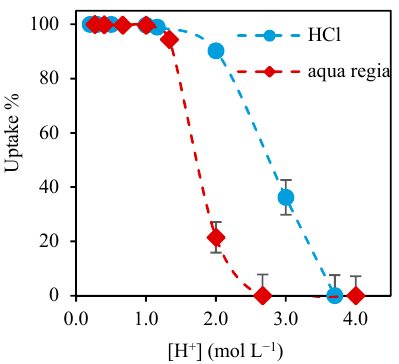
Figure 1. Effect of hydrogen ion concentration ([H + ]) on the uptake of gold by the pine bark tannin resin from HCl and HCl/HNO 3 (aqua regia) aqueous solutions.